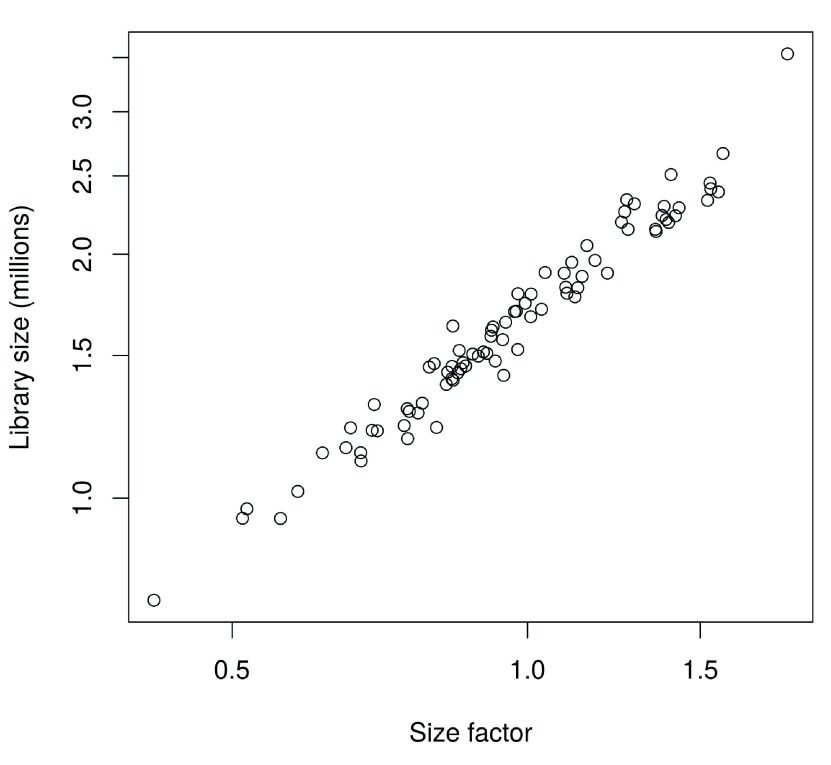
Size factors from deconvolution, plotted against library sizes for all cells in the HSC dataset.Axes are shown on a log-scale.